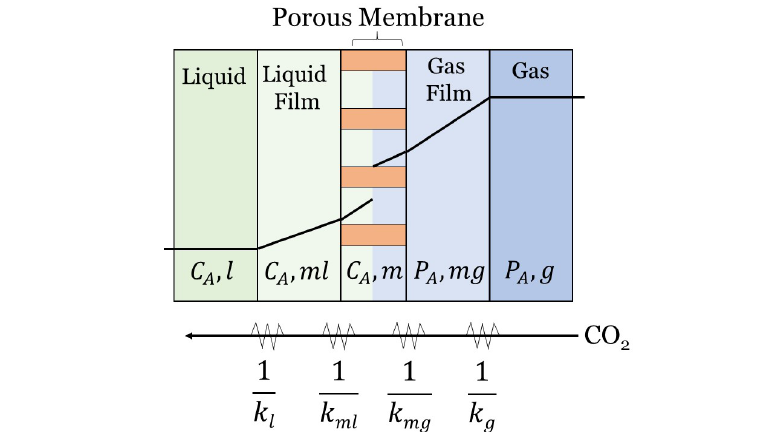
Figure 4. A resistance-in-series illustration for CO 2 crossing a membrane in a HFMC with partial membrane wetting, where both liquid and gas fill the membrane